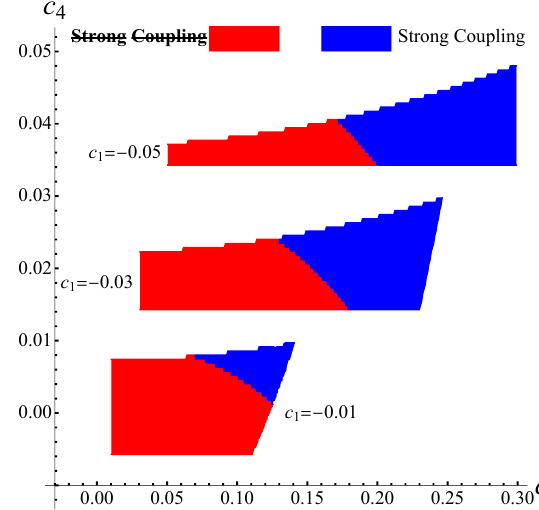
Figure 3. Parameter subspaces (colored areas) allowed by the experimental